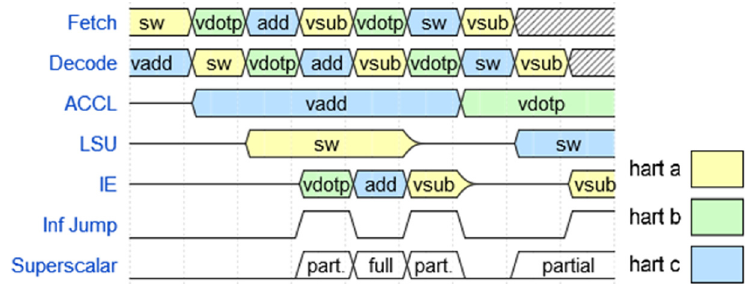
Figure 3. Hart interleaving and hart stall timing diagram.